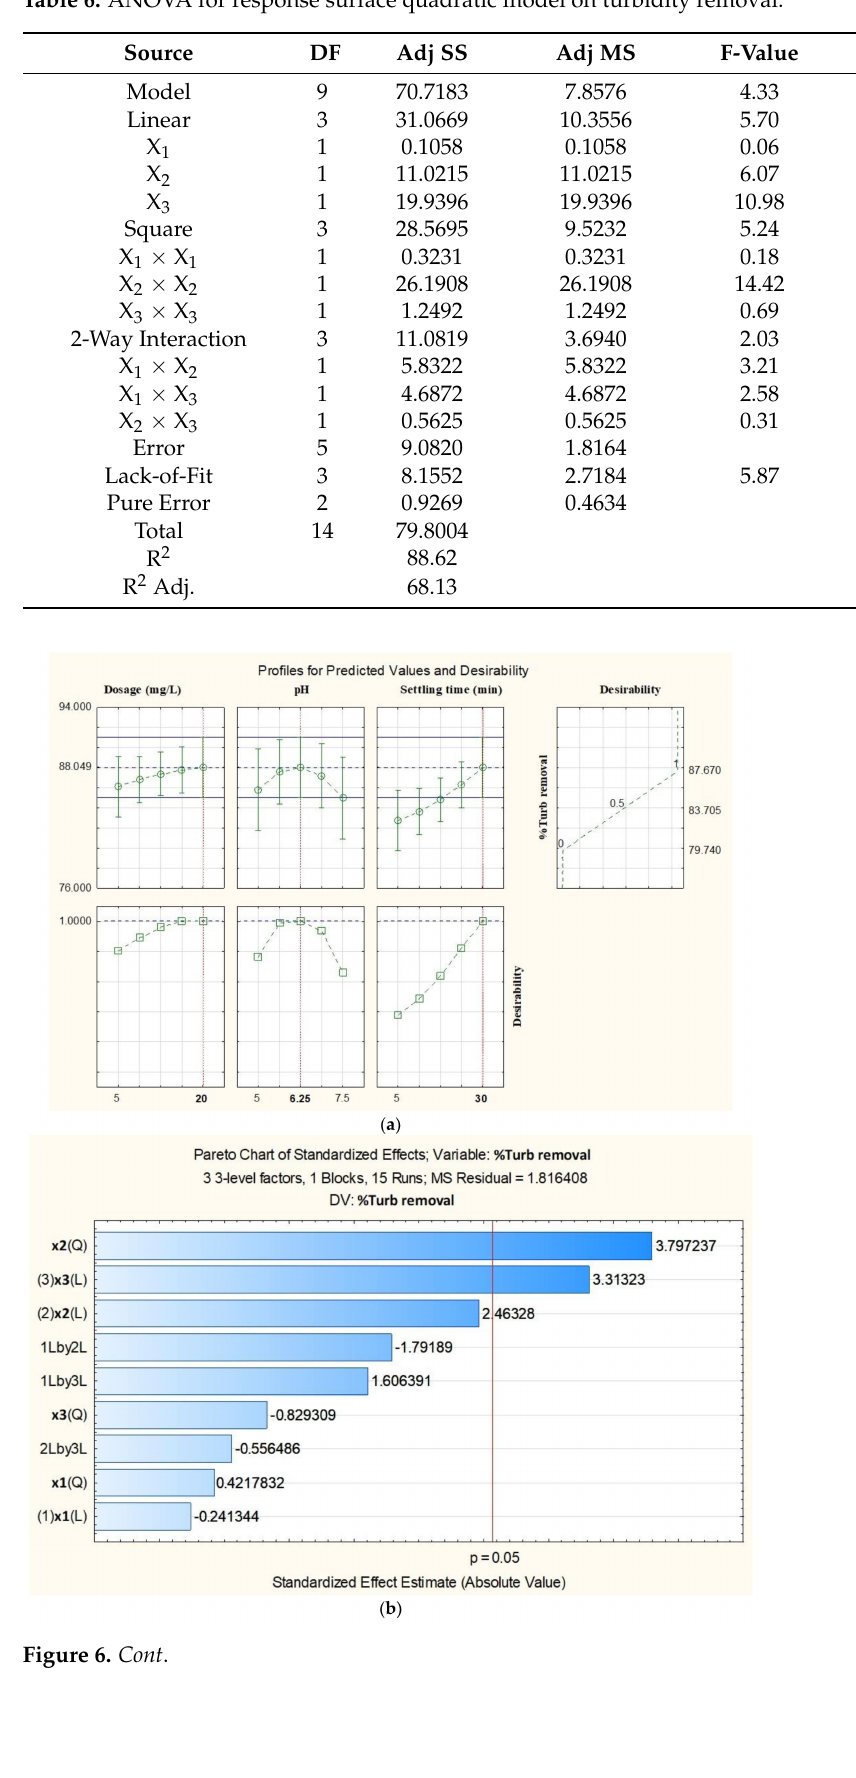
Table 6. ANOVA for response surface quadratic model on turbidity removal.